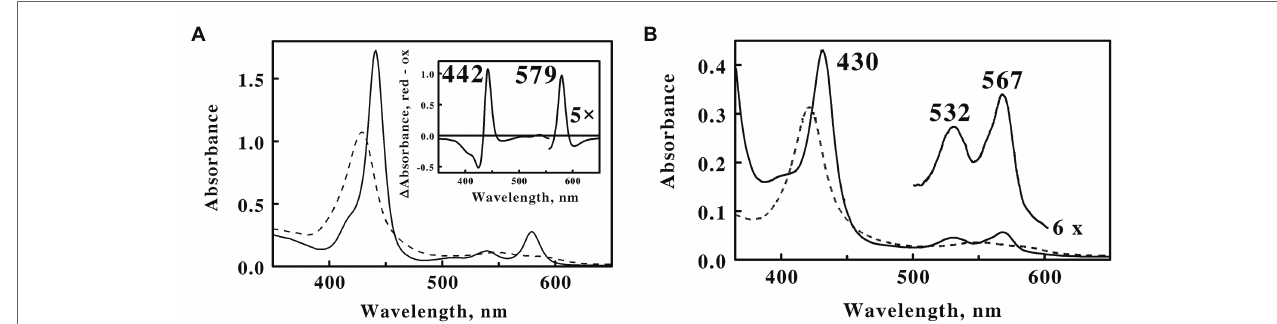
FIGURE 5 | Visible absorbance spectra of cytochrome 579 purified from cell-free extracts of L. ferriphilum . (A) Spectra of oxidized ( dashed line ) and reduced ( solid line ) cytochrome 579 at 160 μ g/ml. Both spectra were determined in 0.01 N sulfuric acid at 25 ° C. The absorbance spectrum of the reduced cytochrome was determined 10 min after mixing the sample of oxidized cytochrome with an excess of ferrous sulfate. Inset , a difference spectrum representing the absolute spectrum of the Fe(II)-reduced cytochrome minus that of the oxidized cytochrome. (B) Alkaline pyridine hemochromogen spectra of cytochrome 579 at 45 μ g/ml. Spectra: final spectrum of the ferric heme, dashed curve ; and spectrum of the ferrous heme, solid curve